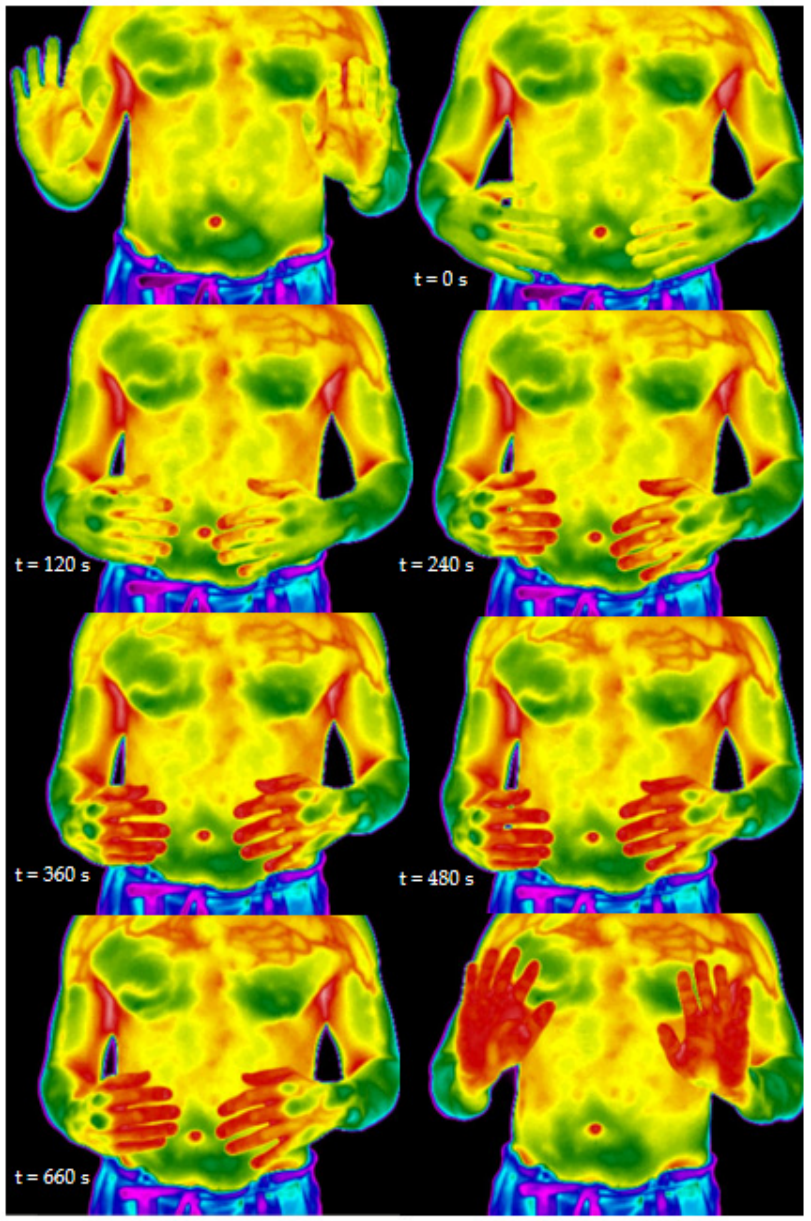
Figure 11. Thermograms of the “Qigong” exercise known as “White Ball”. Reprinted with permission from ref. [197]. Copyright 2019 Elsevier (Amsterdam, The Netherlands) and Copyright Clearance Center (Danvers, MA, USA).